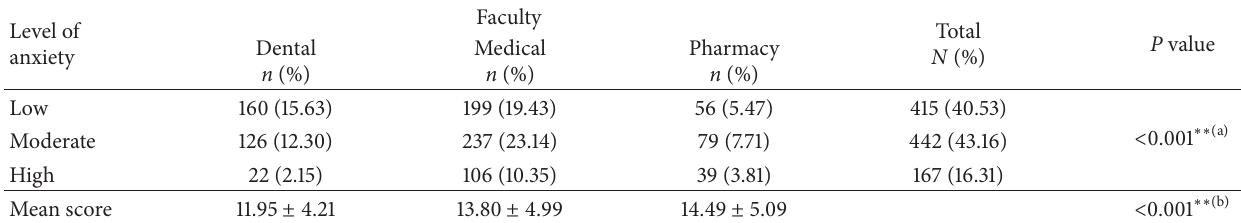
Table 2: Distribution of study subjects according to field of study and level of dental anxiety. Level of